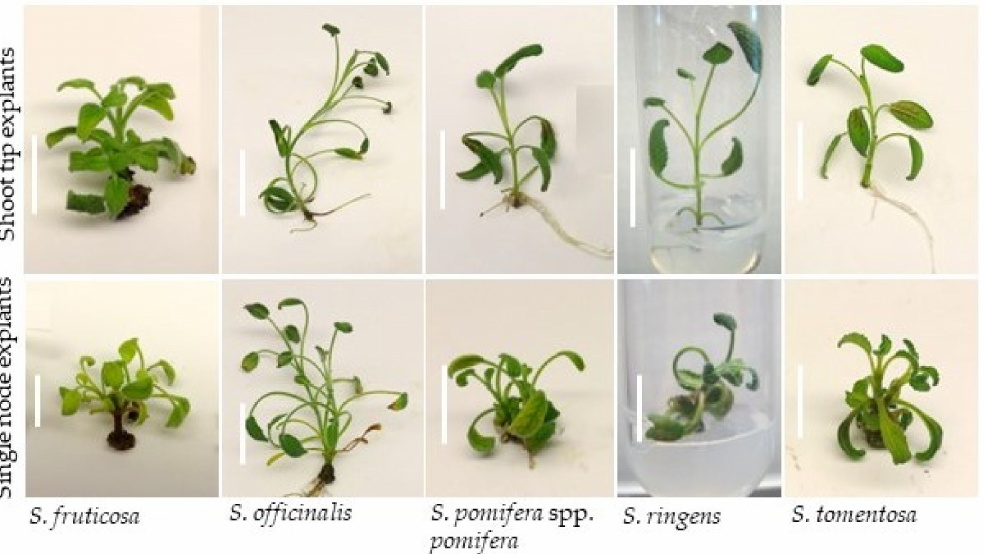
Figure 3. Typical responses of shoot tip and single node explants excised from in vitro seedlings of Salvia spp., during the in vitro establishment stage on hormone-free MS medium. Size bars = 1.0 cm.